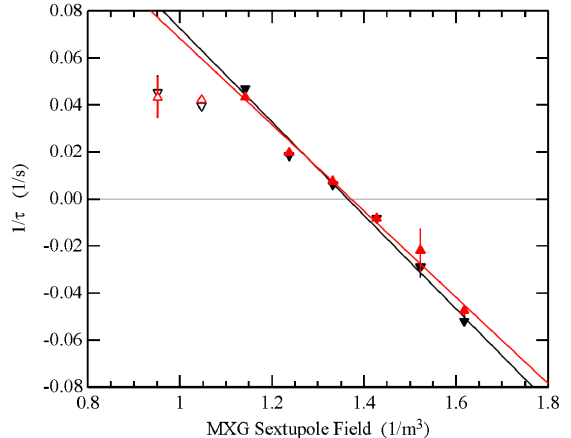
FIG. 19. Measurements made with the long beam of 1 / τ as a function of the G sextupole field (Scan 1). The S field is zero. The optimum field value is indicated by a dashed line.